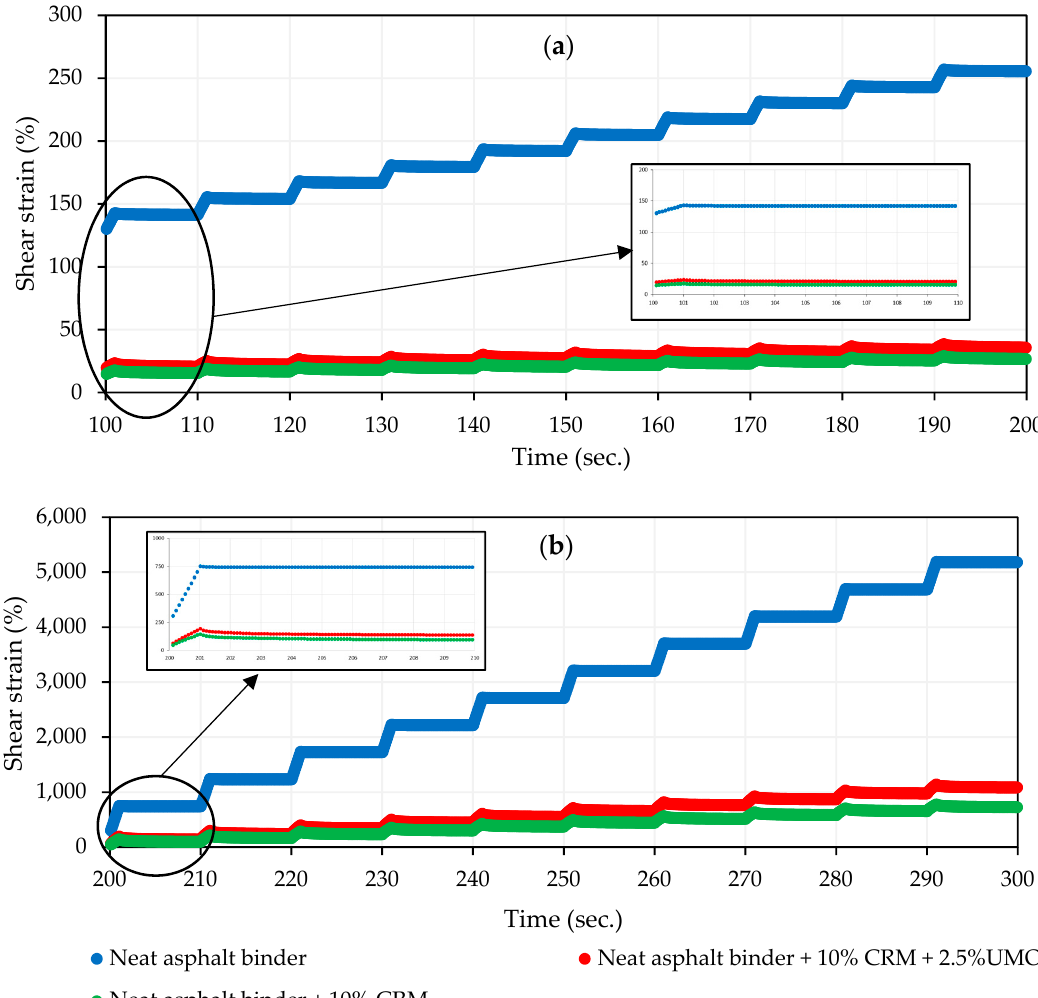
Figure 14. MSCR results for PG 64-22 neat and modified binders interacted at 190 °C—50 Hz—62 min, tested at 60 °C: ( a ) 0.1 KPa; ( b ) 3.2 KPa shear stress.